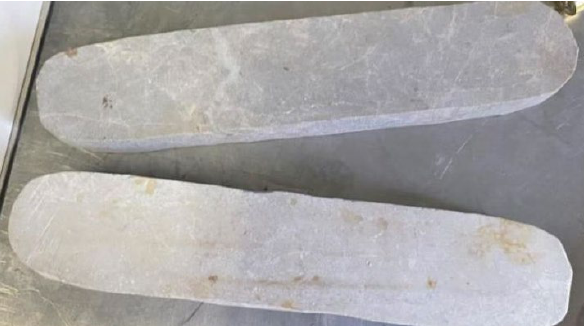
Figure 6. Experimental core.